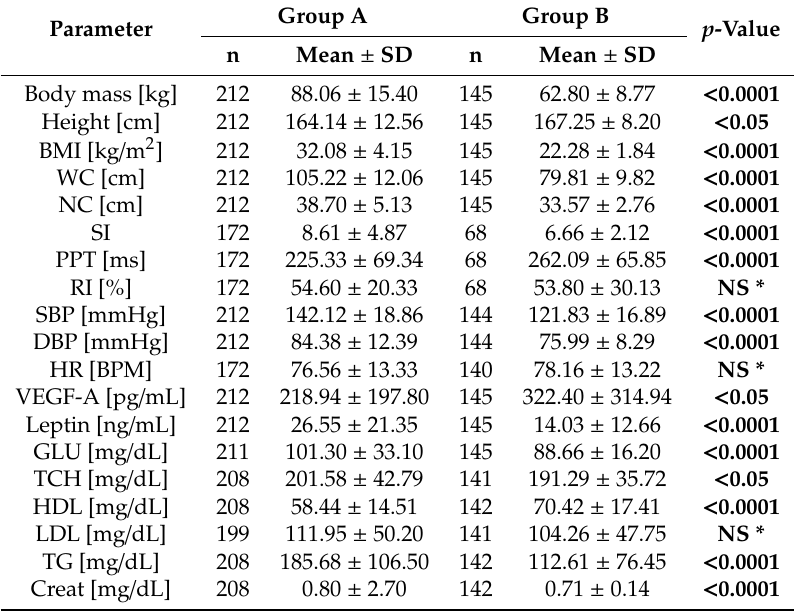
Table 2. Comparison of analyzed parameters between group A and